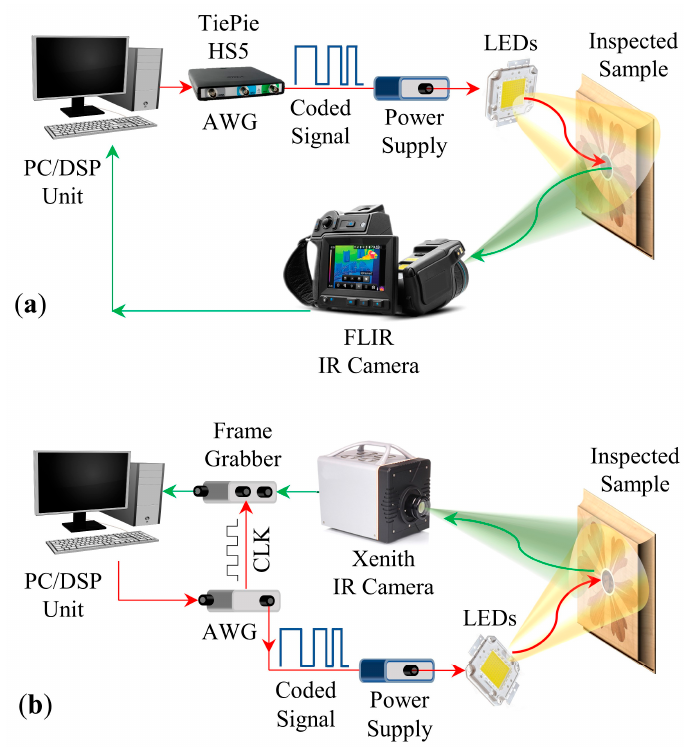
Figure 3. Pulse-compression thermography (PuCT) experimental setups: ( a ) the far-infrared and ( b ) mid-infrared experimental setups.